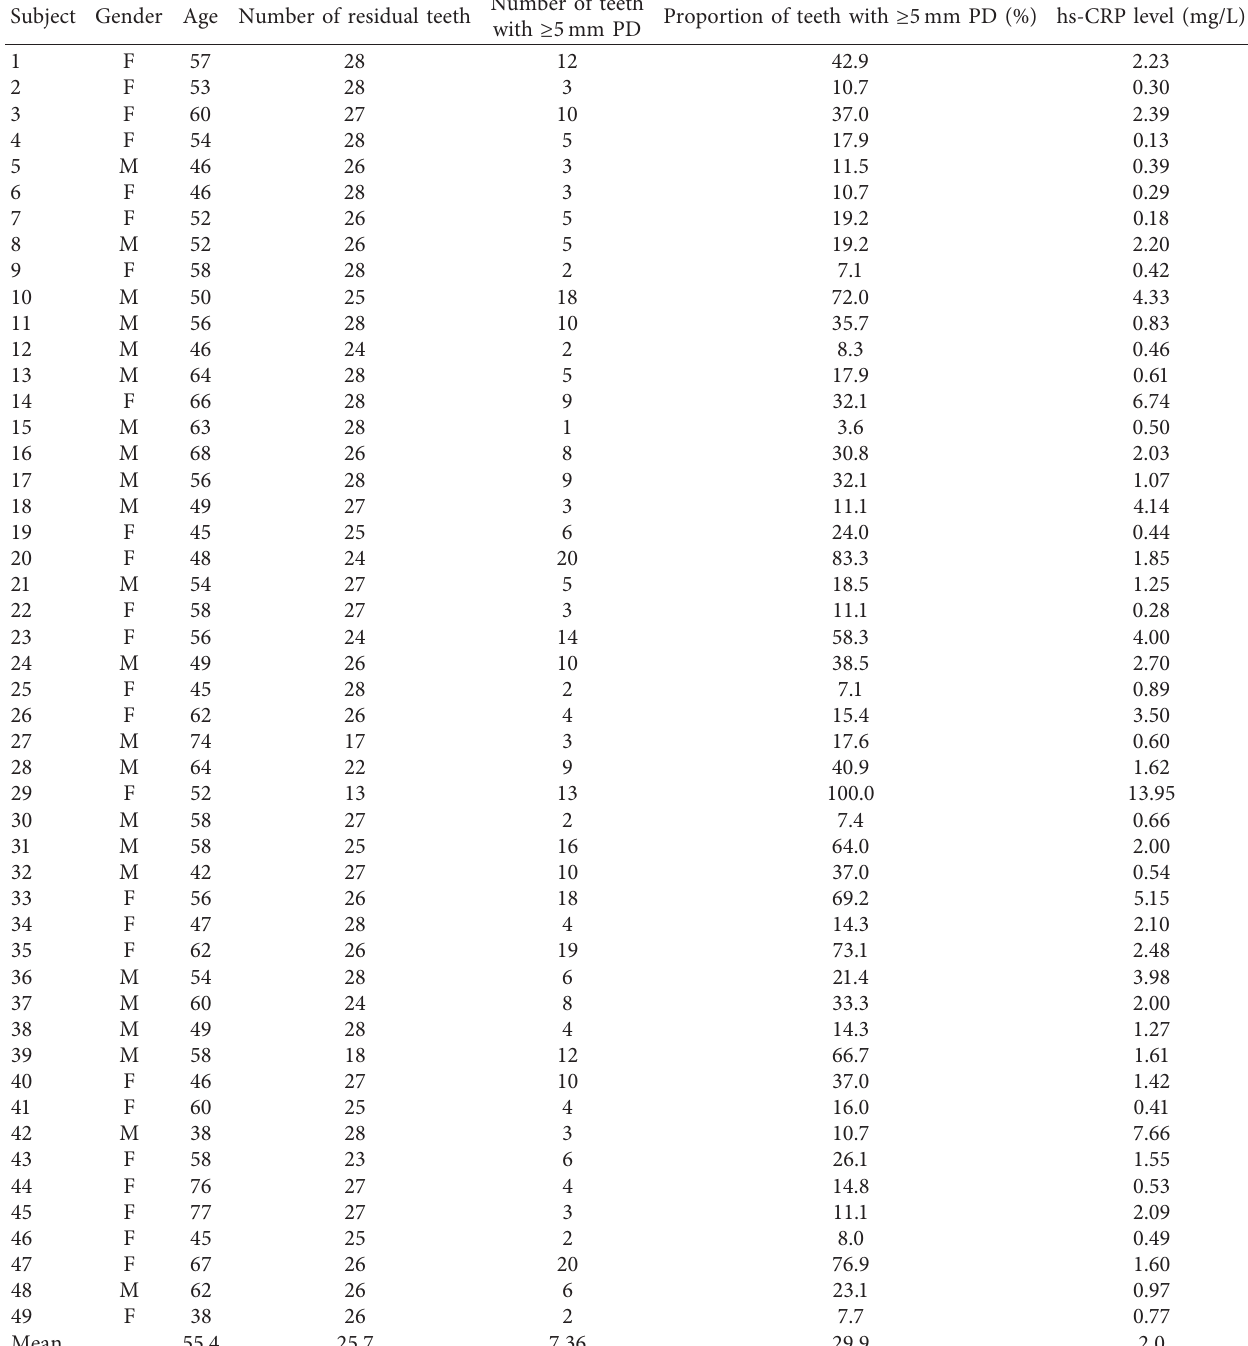
Table 1: Subject